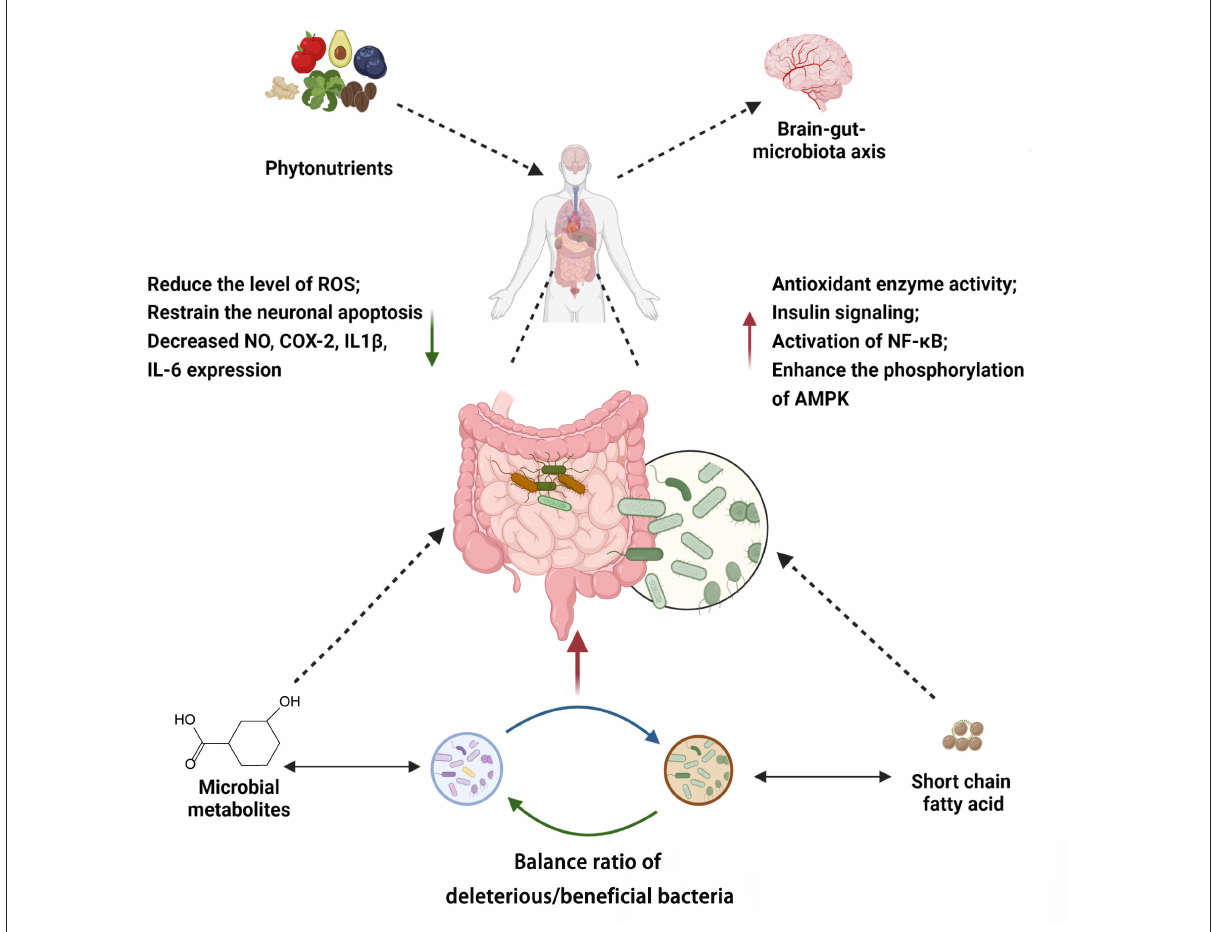
FIGURE8 Summary of mechanisms associated with phytochemicals modulating gut microbiota. Created with